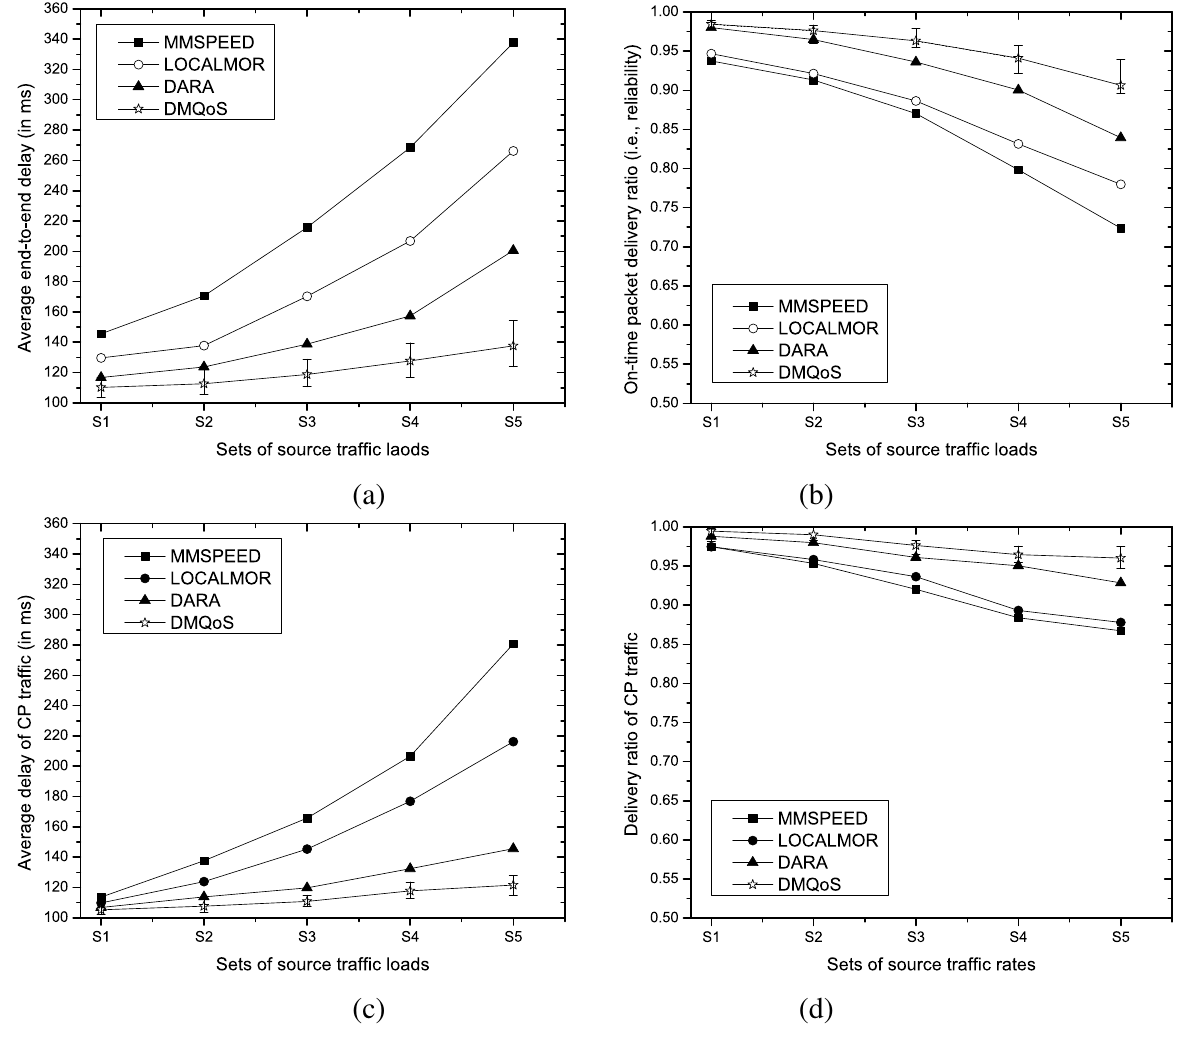
Figure 3. Performance comparisons for varying traffic loads- (a) average end-to-end delay of all data packets, (b) on-time packet delivery ratio i.e. , the achieved reliability, (c) average delay of CP traffic and (d) reliability of CP